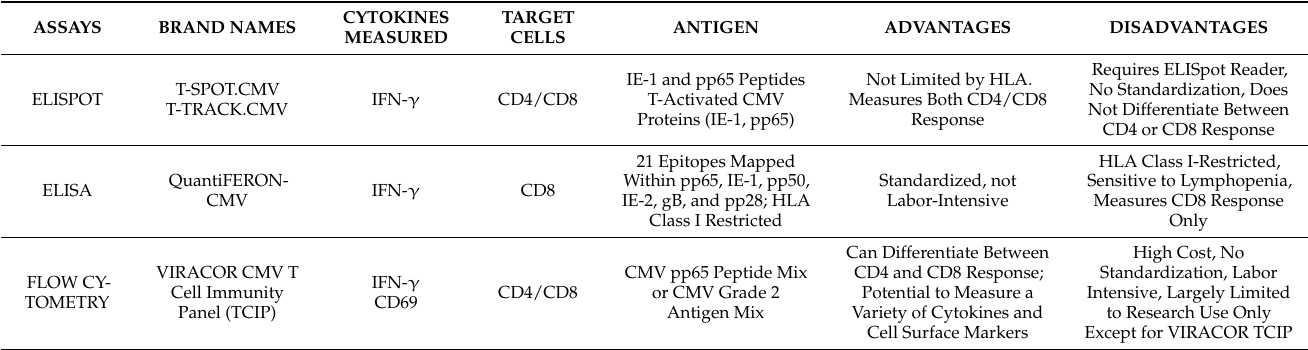
Table 1. Overview of CMV T cell assays used to measure CMV-specific immune